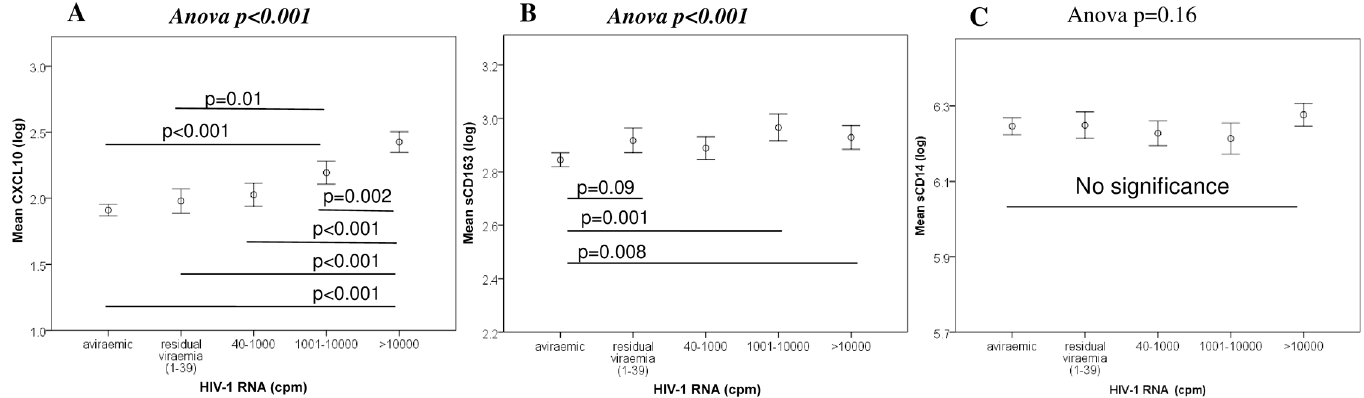
Fig 1. Differing correlation outcomes between the three plasma biomarkers and HIV-1 RNA levels. A significant correlation was recognised between HIV-1 RNA levels with CXCL10 (A) and sCD163 (B) while there was no significance with sCD14 (C).